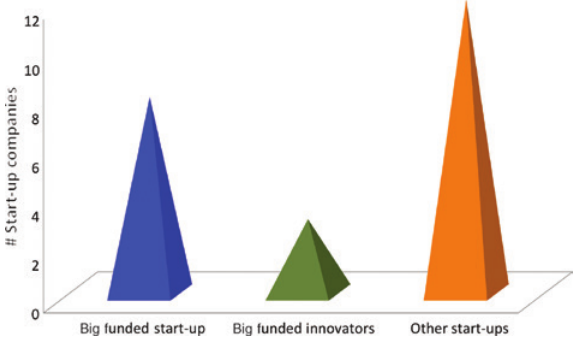
Figure 10: A breakup of entrepreneurial ventures in nanomedicine in India (source: compiled by authors).